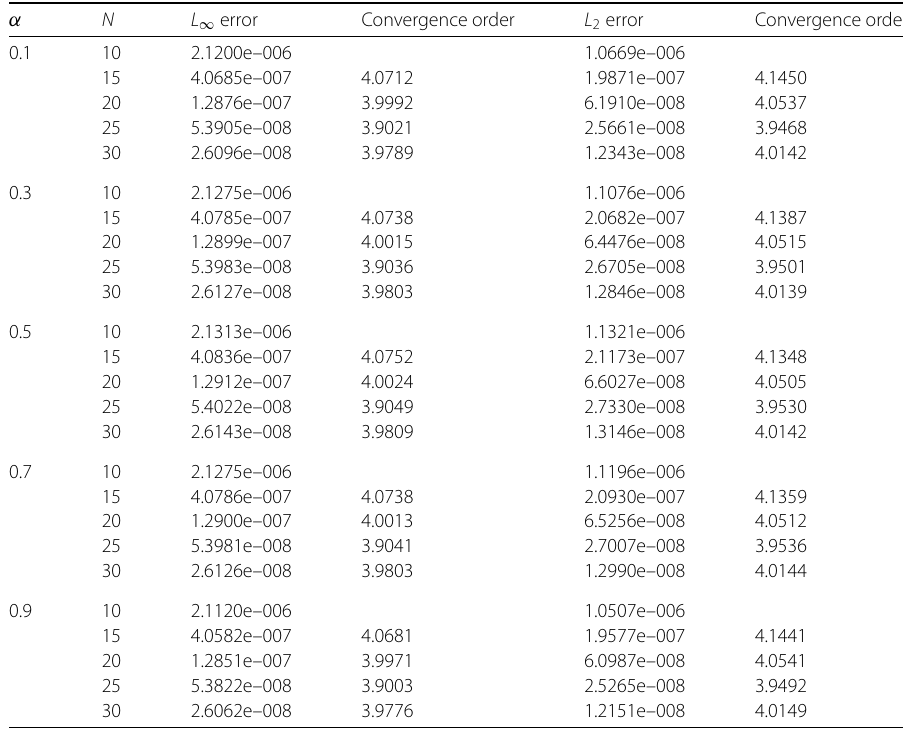
Table 4 The L ∞ , L 2 errors and spatial convergence orders for Example